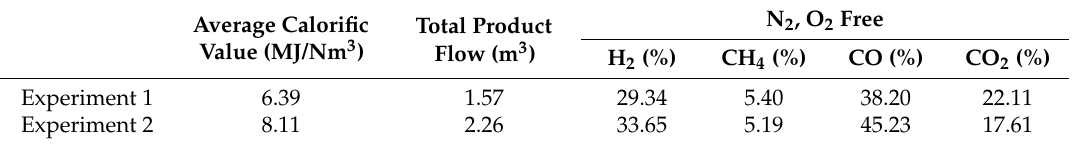
Table 2. Typical product gas data (0.5~3.0 h for experiment 1, 0.5~1.5 h for experiment 2).